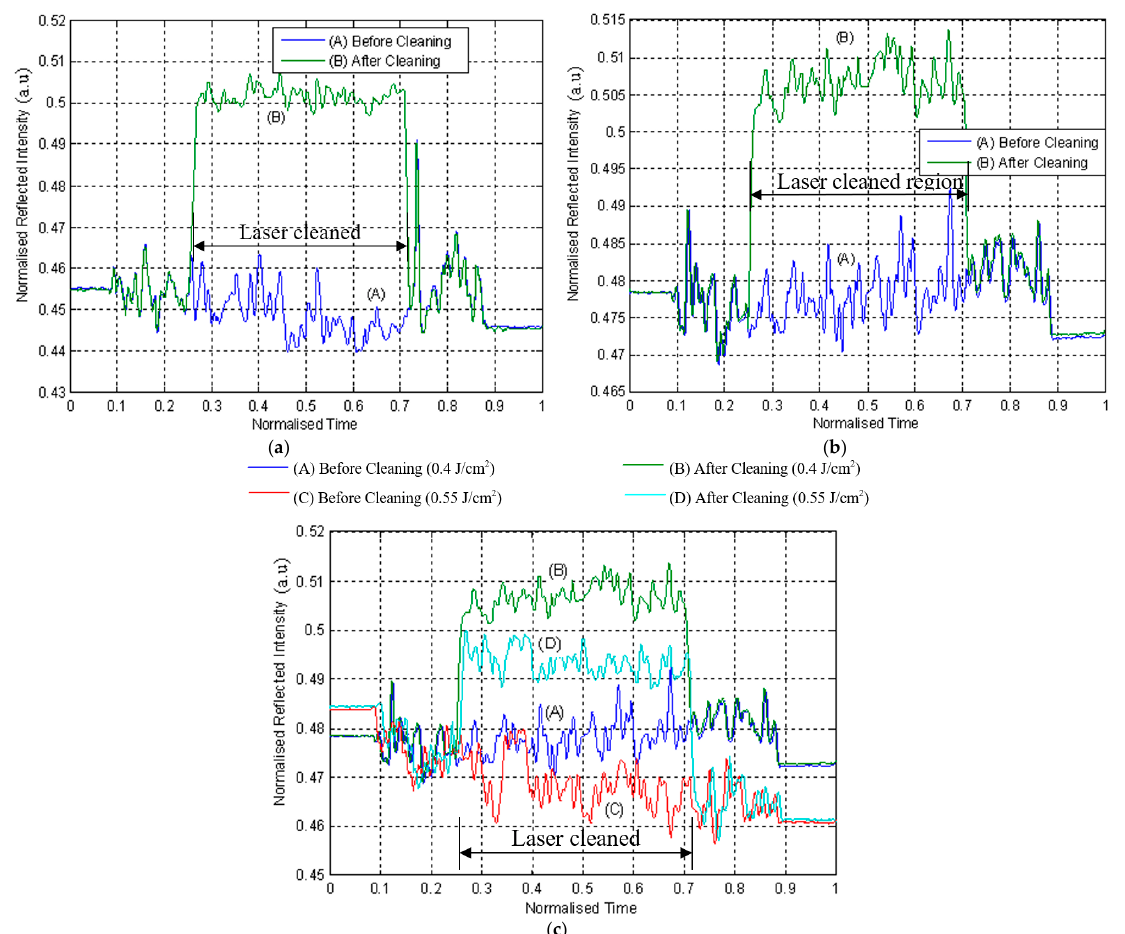
Figure 7. Effects of laser cleaning on PBR intensity over an area. ( a ) Without any added contaminants (beam size = 1 mm 2 , fluence = 0.55 J/cm 2 , No. of pulse per position = 30, frequency = 10 Hz, monitoring laser wavelength = 635 nm), ( b ) With contaminants (beam size = 1 mm 2 , fluence = 0.55 J/cm 2 , No. of pulse per position = 30, frequency = 10 Hz, monitoring laser wavelength = 635 nm), ( c ) With contaminants and for various laser fluences (No. of pulse per position = 30, frequency = 10 Hz, monitoring laser wavelength = 635 nm).